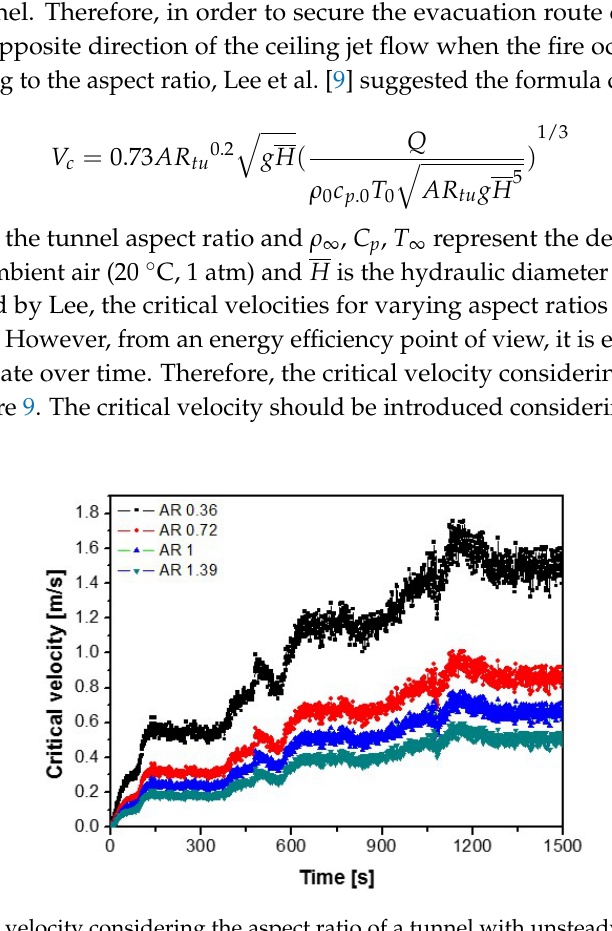
Figure 9. Critical velocity considering the aspect ratio of a tunnel with unsteady heat release rate.